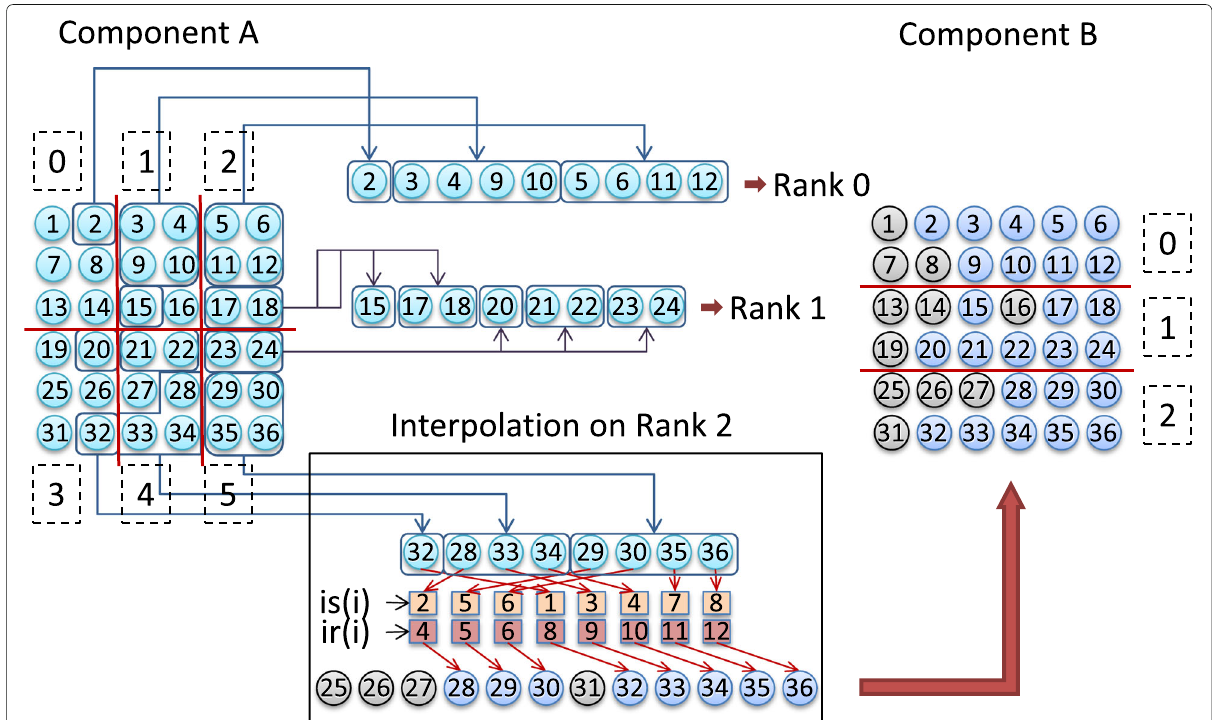
Fig. 2 Data exchange diagram. The gray circles represent masked value. Therefore, only the grid point value indicated by the blue circle is passed from component A to component